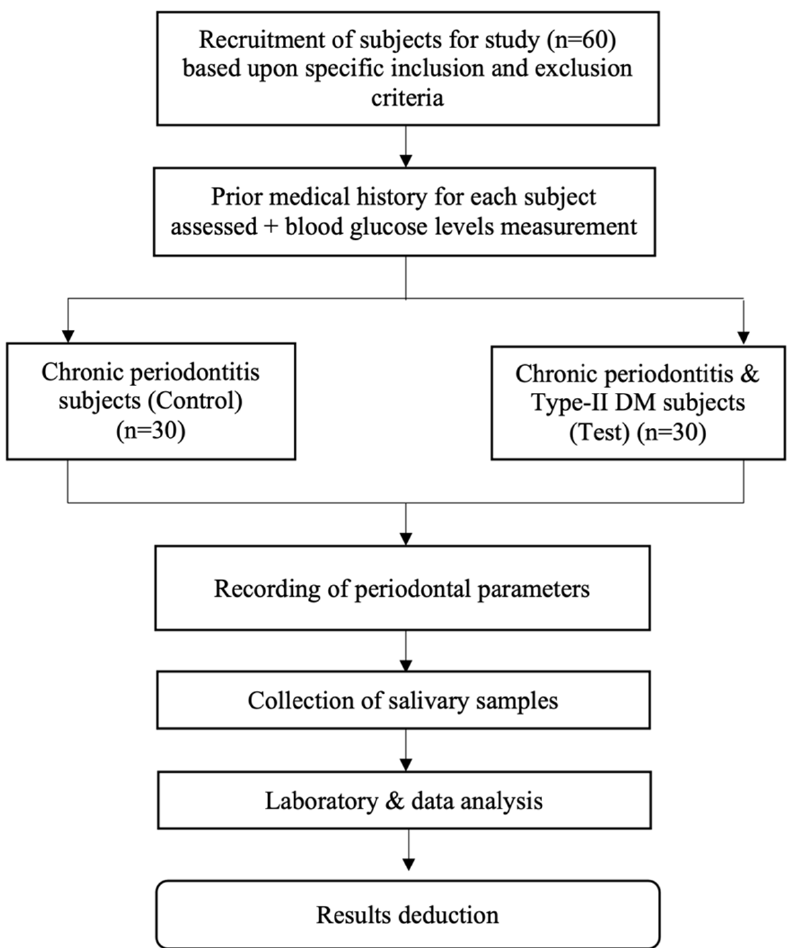
Figure 3. Flowchart of the